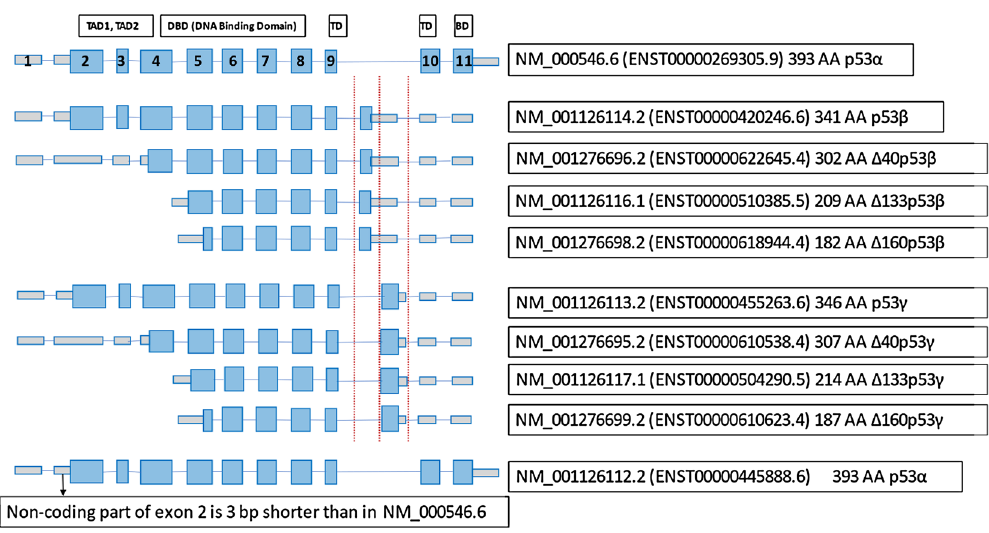
Figure 1. TP53 isoforms with exon-exon junctions distinct from main NM_000546.6 isoform. TAD—Trans Activation Domain, TD—Tetramerization Domain, BD—Basic